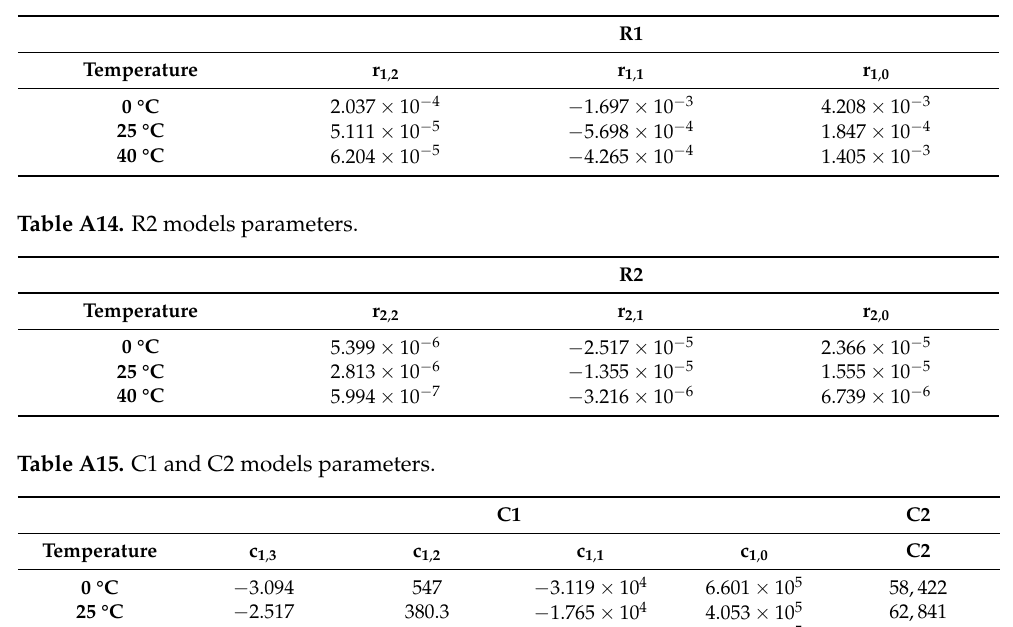
Table A13. R1 models parameters.